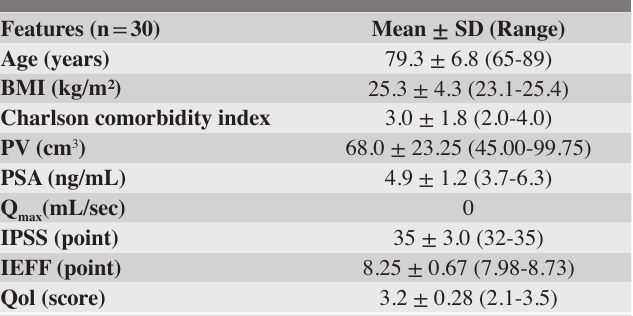
Table 1. Sociodemographic and Clinical Data of the